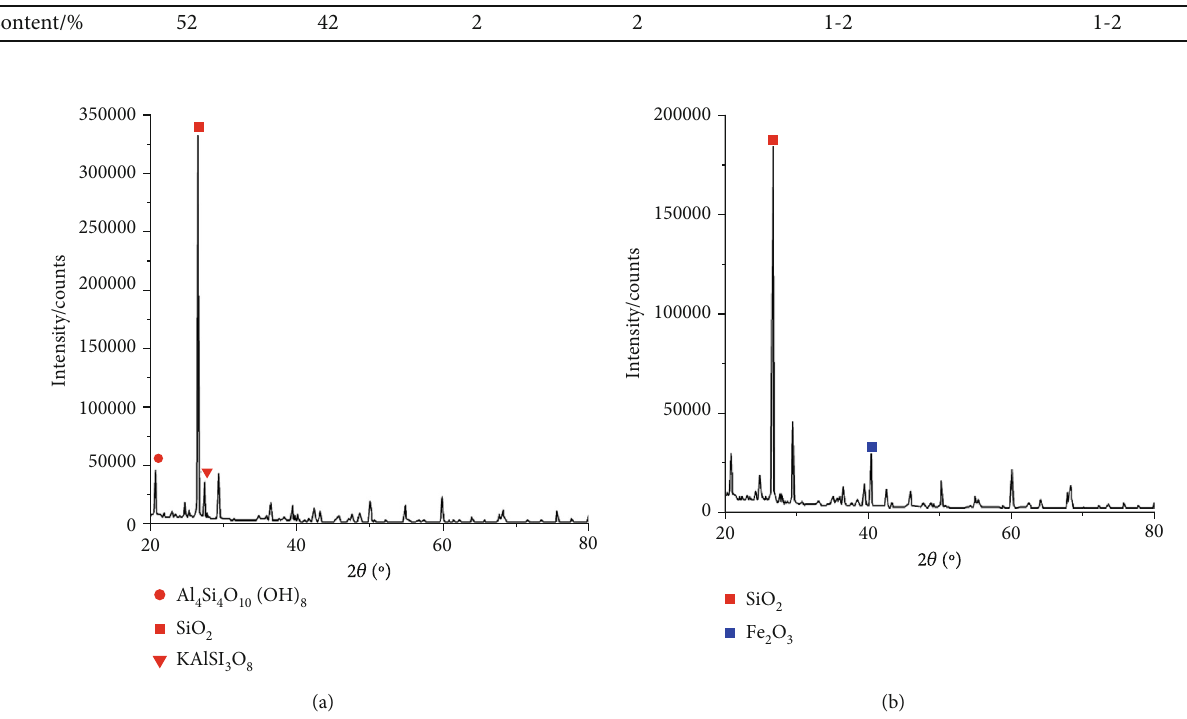
Figure 2: XRD patterns of concretion sandstone. (a) Sandstone matrix. (b)